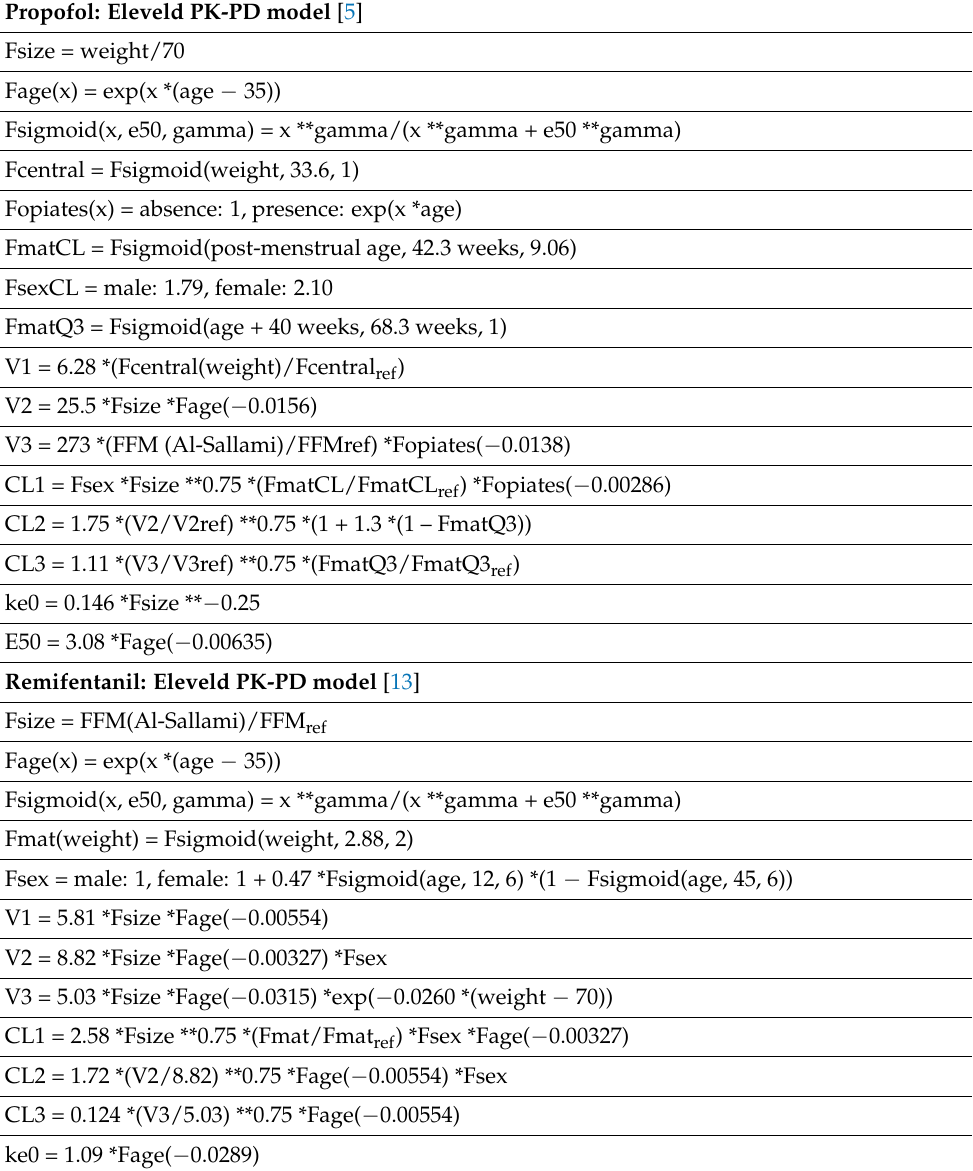
Table 3. The four general purpose pharmacokinetic